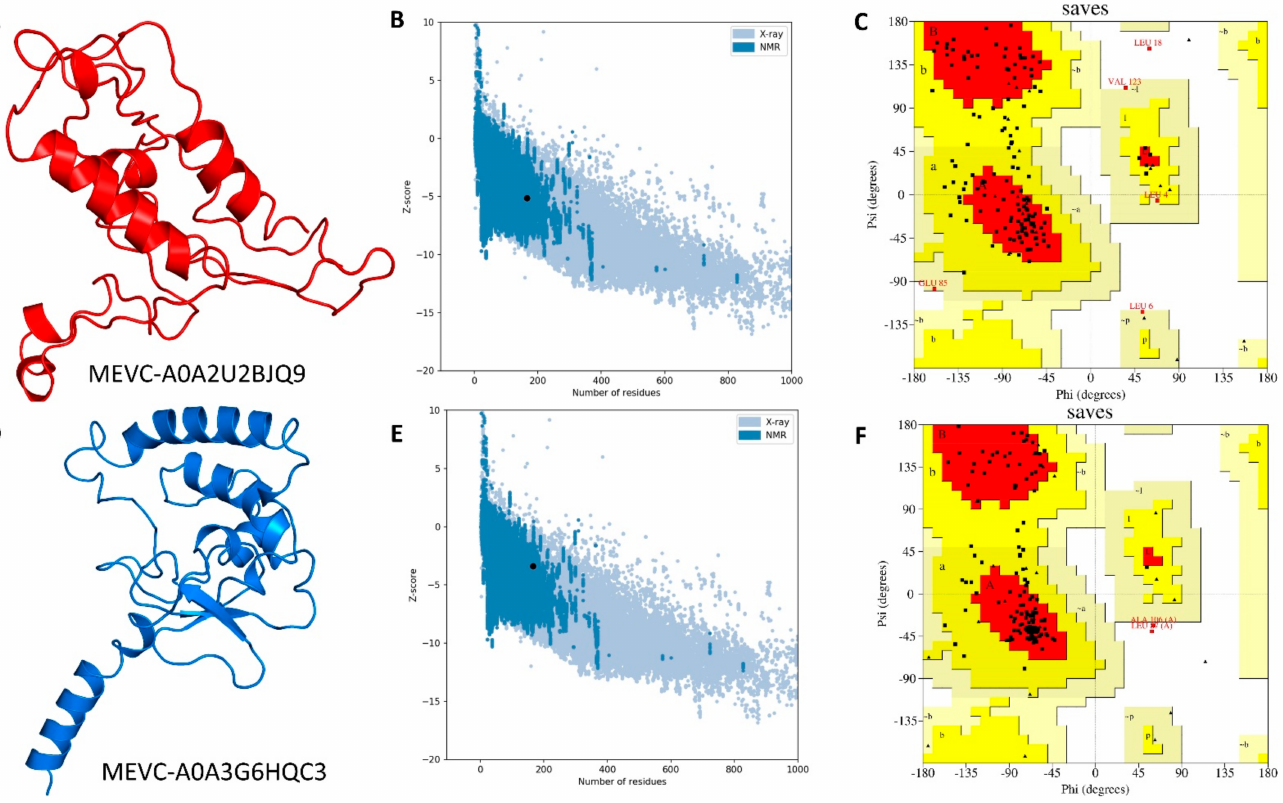
Figure 3. The modelled structures and validation analysis of the target-specific MEVC designs against Alcaligenes faecalis. Figures ( A – C ) represent the 3D modelled structure, Z-score graph, and Ra- machandran plot for the vaccine construct (MEVC-A0A2U2BJQ9), while ( D – F ) show the 3D modelled structure, Z-score graph, and Ramachandran plot for the vaccine construct